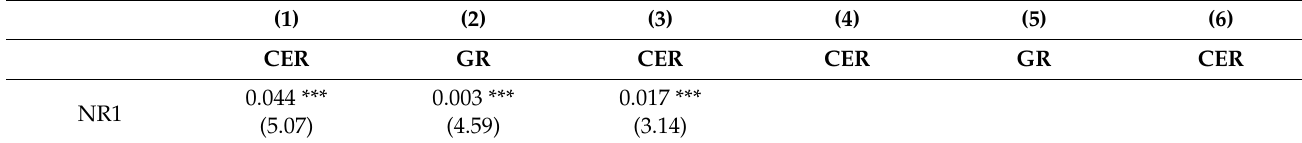
Table 8. Sensitivity test of the independent